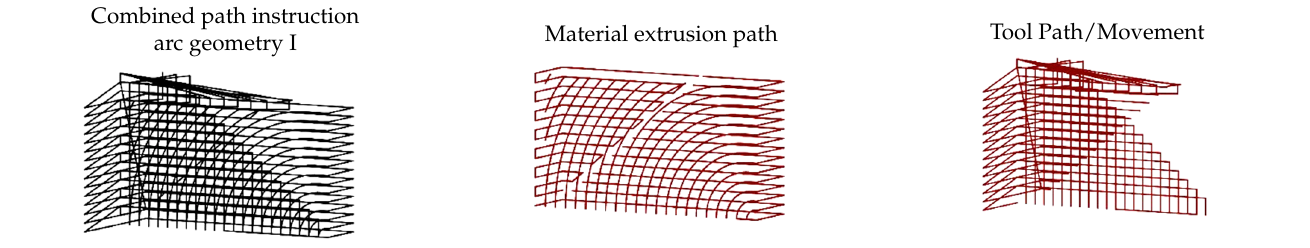
Figure 8. Arc geometry I: front ( a ) and back ( b ).